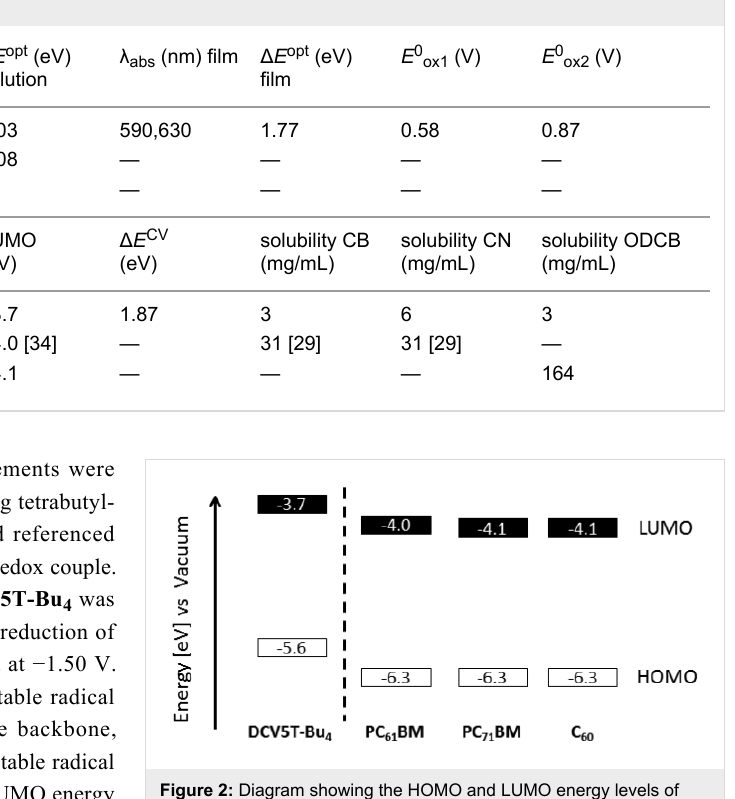
Figure 2: Diagram showing the HOMO and LUMO energy levels of DCV5T-Bu 4 , PCBM derivatives [34,35], and C 60